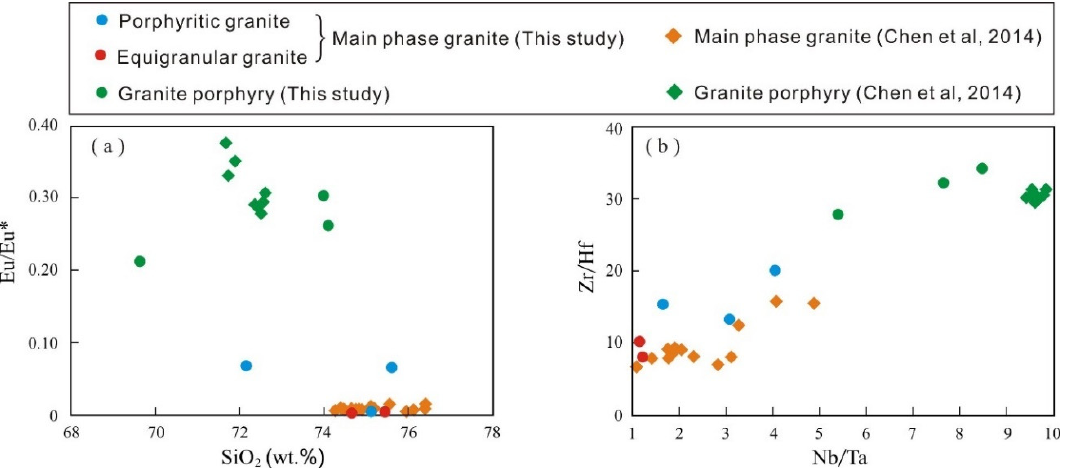
Figure 10. Diagrams of ( a ) SiO 2 vs. Eu / Eu* and ( b ) Nb / Ta vs. Zr / Hf in which the common range of granites is as reported by Jahn et al. [70]. Data cited from Chen et al. [20].